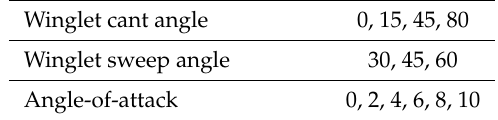
Table 1. Design space explored in this study. All the angles are defined in